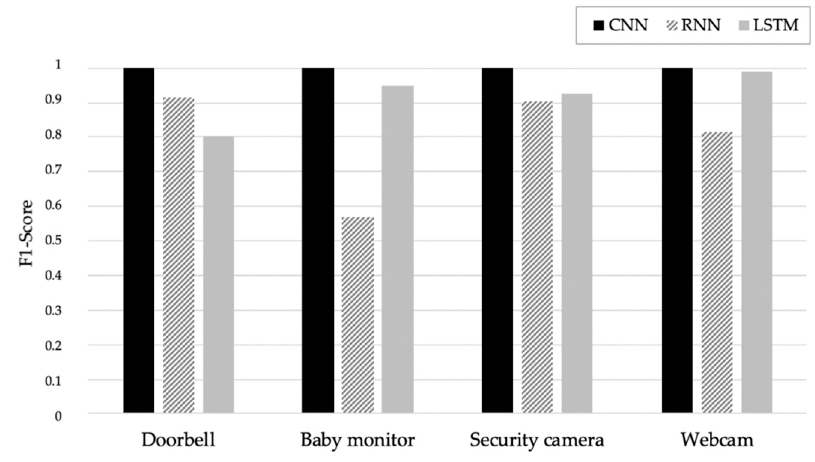
Figure 2. Result of binary classification based on the three DL models.